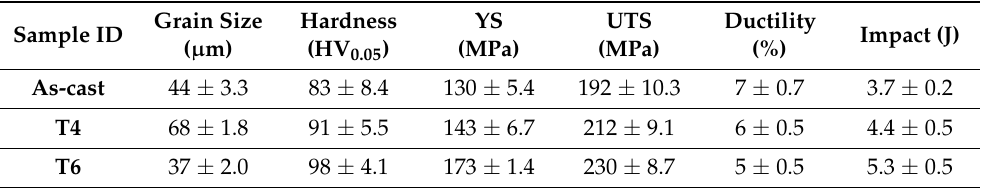
Table 3. Mechanical properties of EV31A Mg alloy.